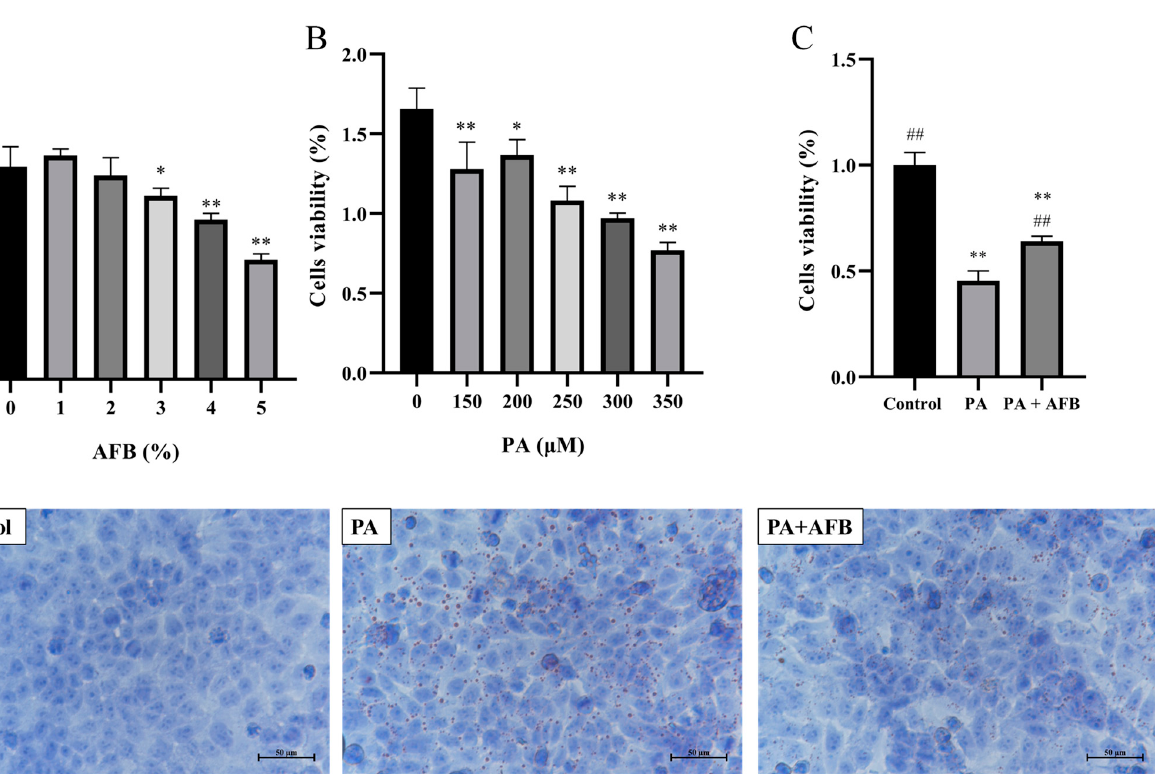
Figure 1. Effect of PA and AFB on the HepG2 cells in the high-fat environment. ( A ) The cell viability after treatments with different concentrations of AFB. ( B ) The cell viability after treatments with different concentrations of PA. ( C ) The cell viability after the treatment of PA or PA + AFB. ( D ) Oil Red O staining of HepG2 cells after treatments with PA or PA + AFB (100×). The results are expressed as the mean ± SD. * p < 0.05, ** p < 0.01 versus the control group and ## p < 0.01 versus the PA group by one-way ANOVA.